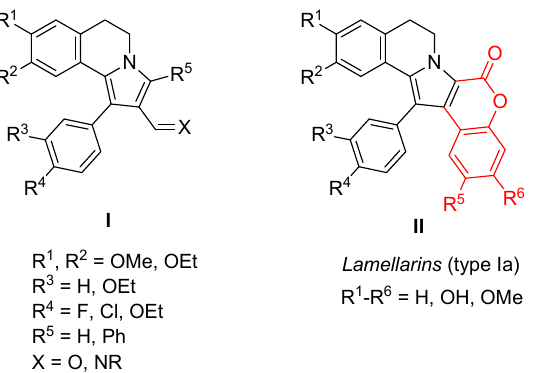
Figure 1. General structure of aldehydes and related imino derivatives of 5,6-dihydro-1-phenylpyrrolo[2,1- a ]isoquinoline (DHPPIQ) compared with the structure of the natural type Ia lamellarins.